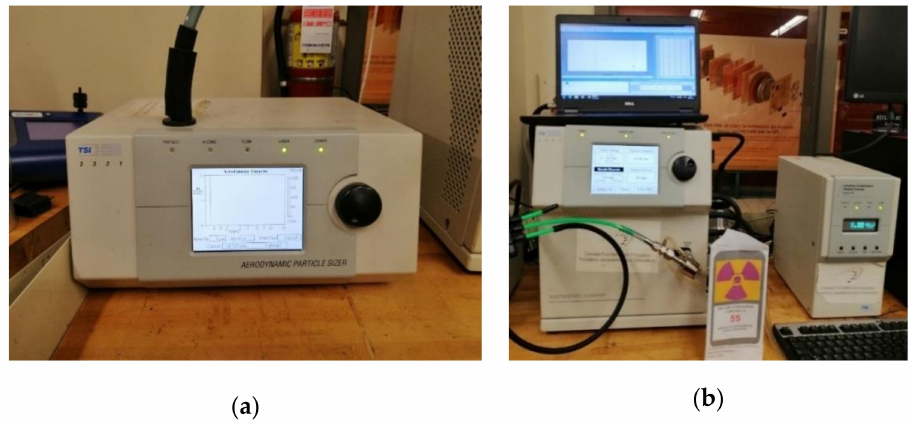
Figure 2. Particle acquisition systems: ( a ) APS, ( b ) SMPS. The measurement of the cutting forces was performed using a Kistler 9255B table dynamometer (Kistler Instrument Corporation, New York, NY, USA), (Figure 3), connected to a data acquisition and analysis. This device measures the cutting forces along the three axes x , y , and z